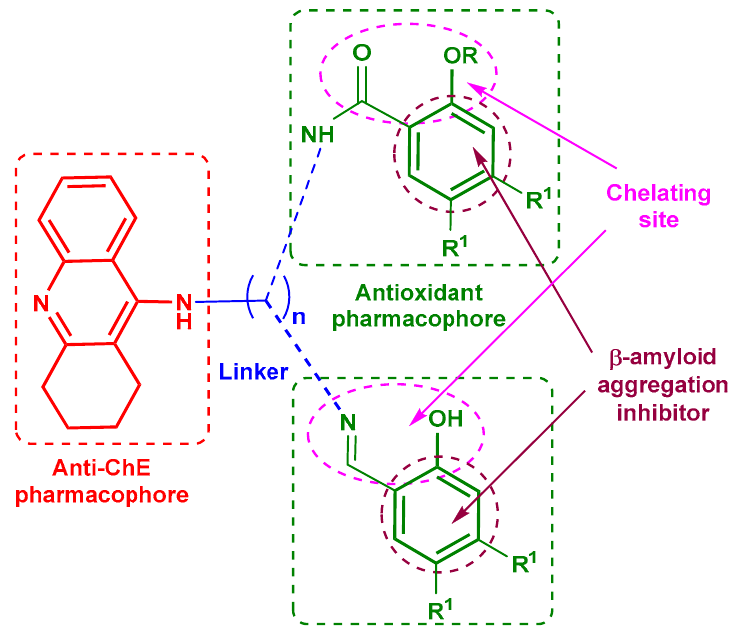
Figure 1. Designed conjugates of tacrine with salicylamide and salicylimine derivatives. Next, the esterase profile of the conjugates, i.e., their inhibitory activity against cholinesterases and a structurally related enzyme, carboxylesterase (CES, EC 3.1.1.1), was determined, and the results were analyzed using enzyme kinetics and quantum